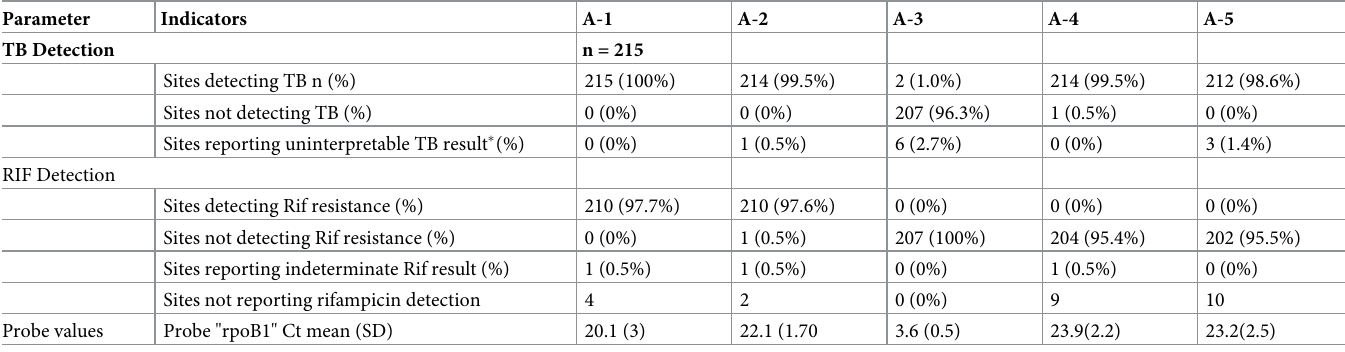
Table 3. Participants’ DTS testing results within six